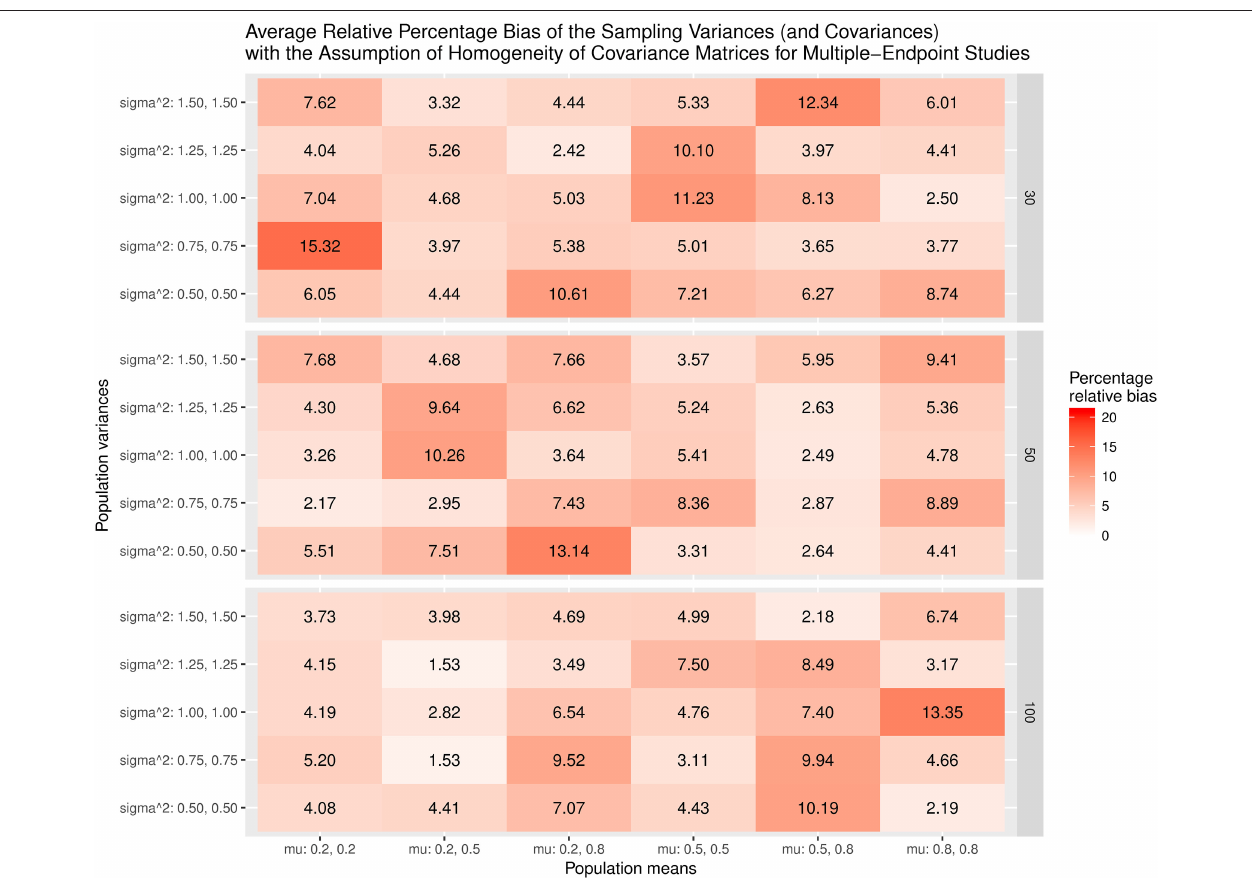
FIGURE 9 | Relative bias of the average of the sampling variances and covariance for the multiple-endpoint studies with the assumption of homogeneity of covariance matrices.